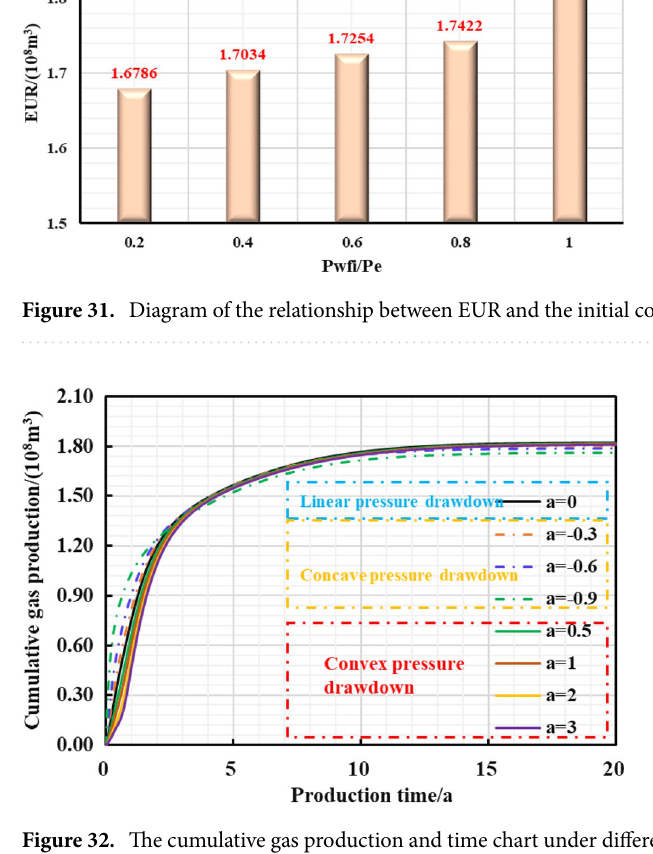
Figure 32. The cumulative gas production and time chart under different pressure drop